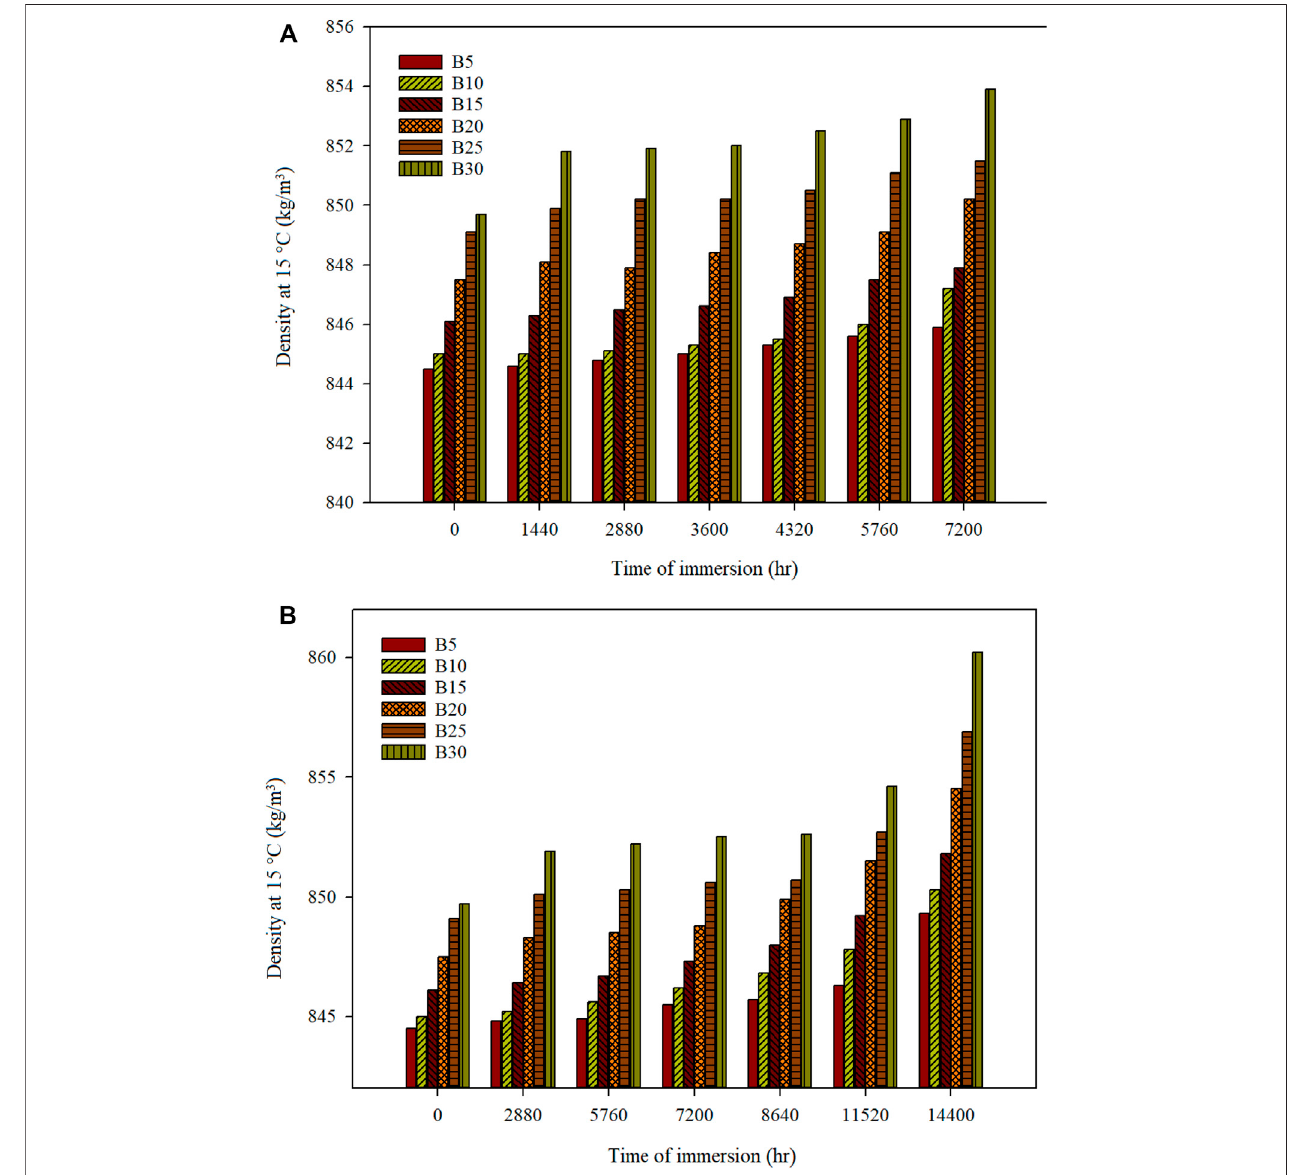
FIGURE 5 | Density at 15 ° C of different biodiesel-diesel blending ratios for (A) mild steel and (B) stainless steel 316 for a speci fi c time of immersion.